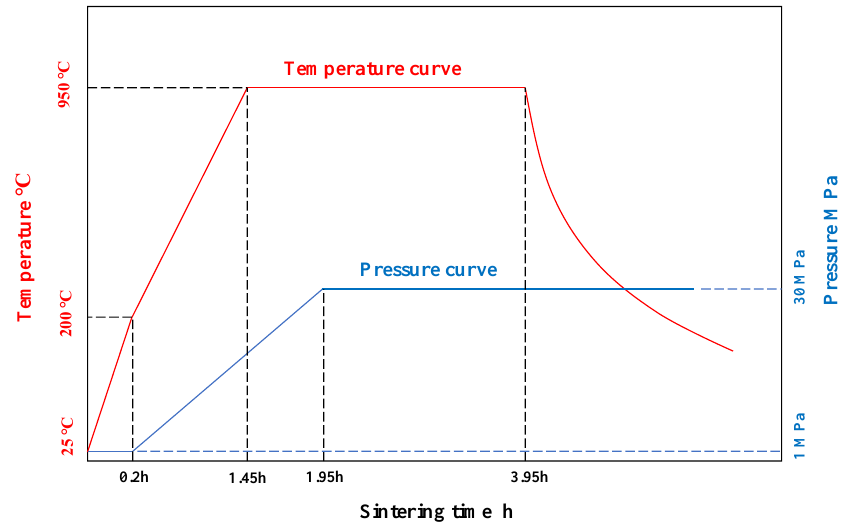
Figure 1. Sintering process of Cu/WC P functionally gradient materials.